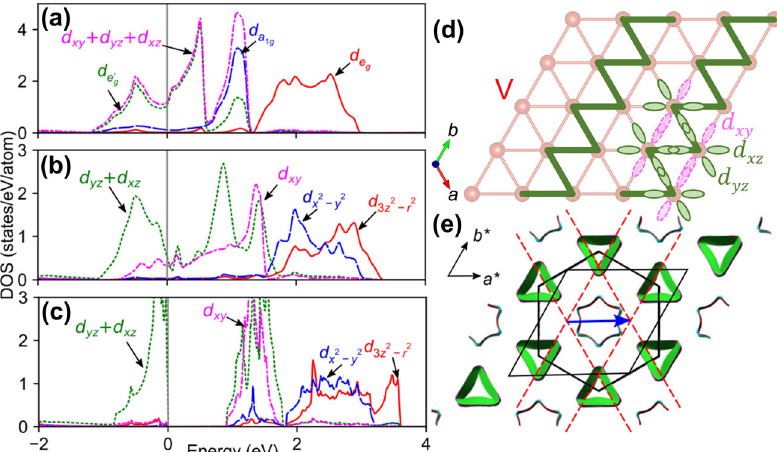
Fig. 4 Calculated electronic structures of LiVS 2 . a Orbital-decomposed partial densities of states (PDOS) in the paramagnetic metallic phase with the average P 3 m 1 structure; the d xy + d yz + d xz component is separated into the e ′ g and a 1 g components in the trigonal crystal fi eld. b Orbital-decomposed PDOS calculated for the local Pm structure. c Orbital-decomposed PDOS calculated for the trimer structure. d Orbital- assisted multiple dimerizations consisting of zigzag chain patterns. e Fermi surfaces calculated using the GGA + U scheme at U = 4